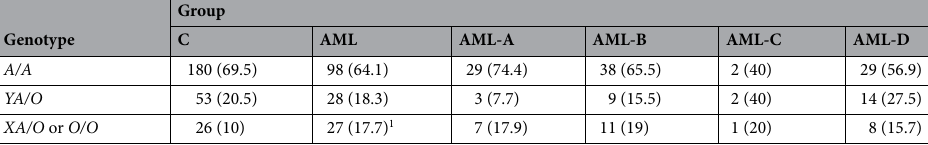
Protein AML versus Curve area 95% CI Significance Cut-off (μg/ml) Sensitivity (%) Specificity